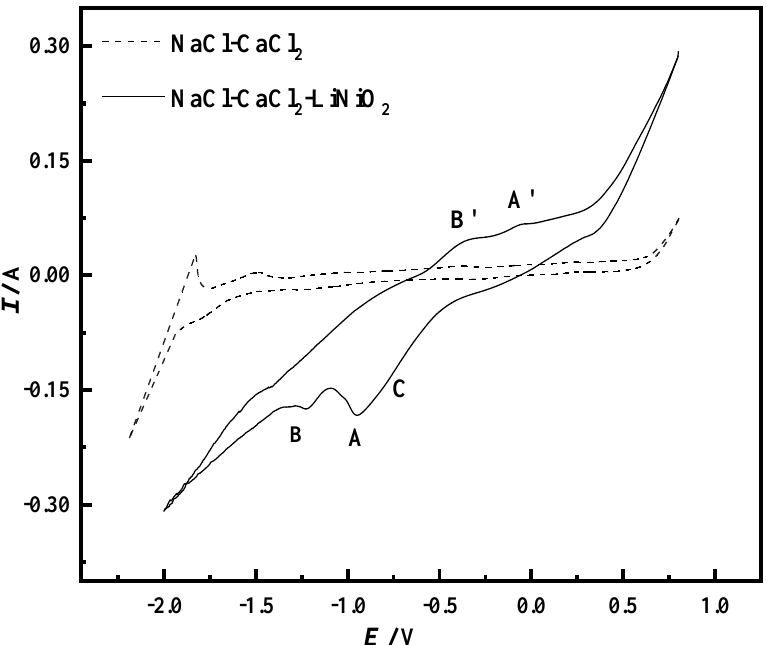
Figure 9. Cyclic voltammetry diagram of Mo cavity electrode filled with or without LiNiO 2 in NaCl-CaCl 2 molten salt (scanning speed: 0.2 V/s, T = 750 ◦ C, reference electrode: Pt electrode). At 750 ◦ C, cyclic voltammetry was performed on the Mo cavity electrode filled with LiNiO 2 at different sweep speeds in the NaCl-CaCl 2 molten salt system. The results are shown in Figure 10.